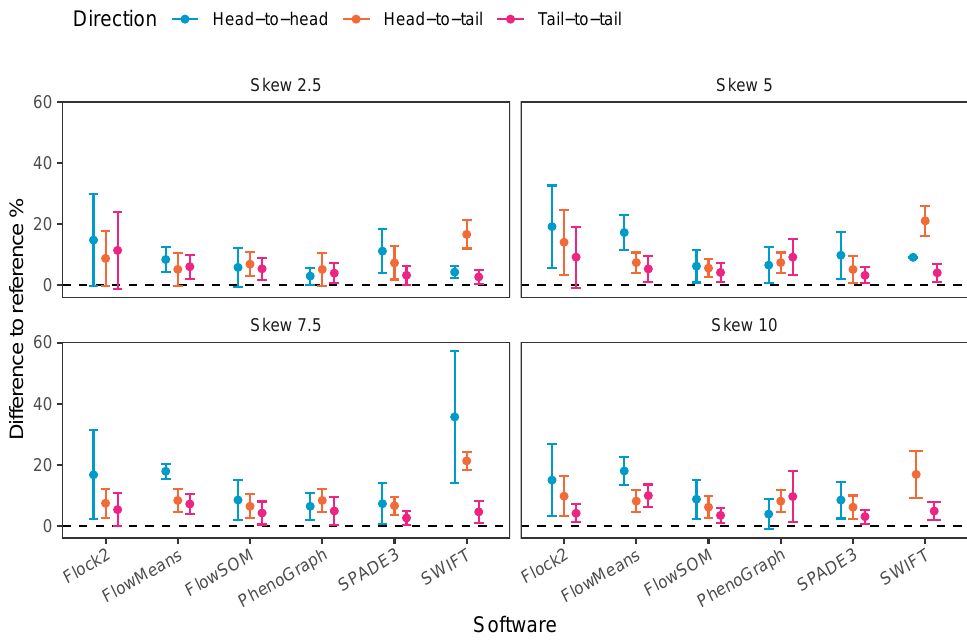
Figure 11. Performance of different software on a dataset with skew cluster orientations facing head to head, head to tail, and tail to